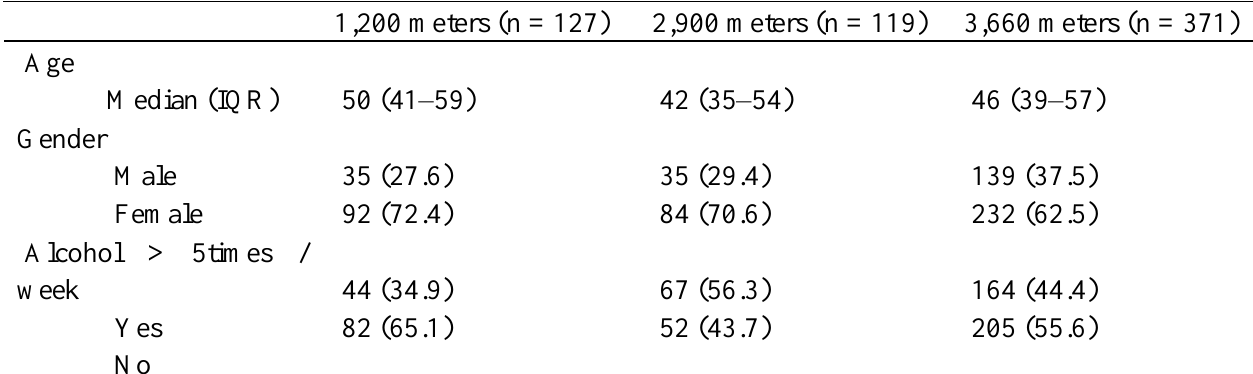
Table 1. Characteristics of subjects by altitude of